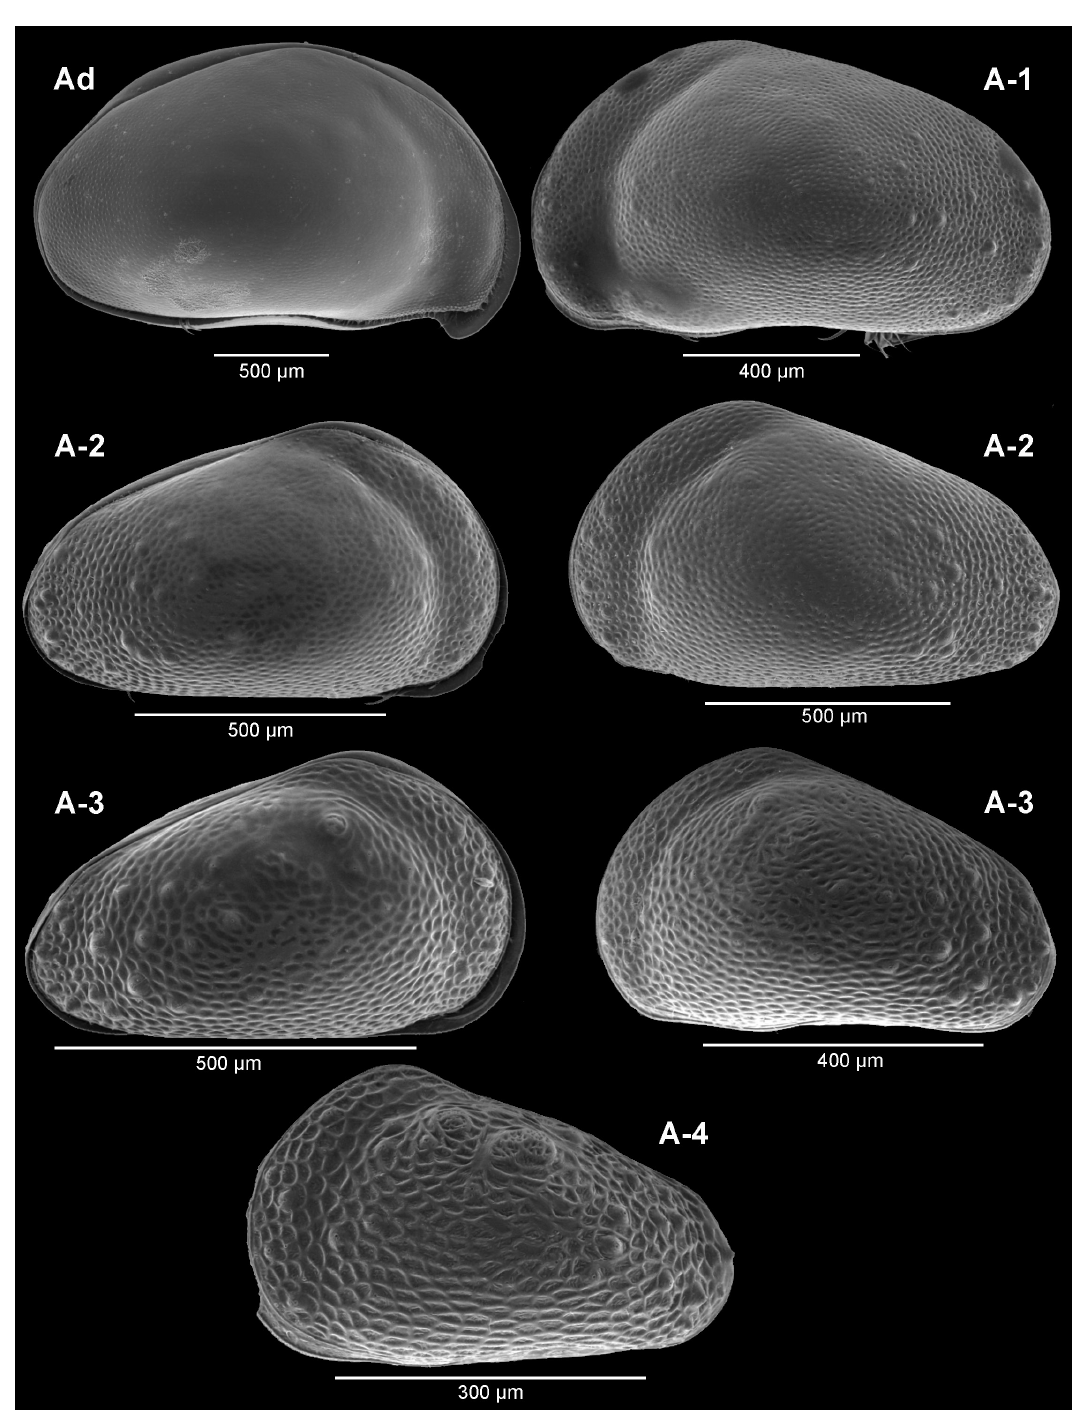
Fig. 14. Bennelongia kimberleyensis Martens et al ., 2012 from Taylor’s Lagoon. Lateral views of carapaces of different moult stages going from adult to A-3 specimens, plus a lateral view of a single LV of an A-4 specimen (bottom image) that is partly broken along its anterior margin. Top left image represents an adult showing the asymmetric valves, with the antero-ventral beak-like expansion of the LV that is the characteristic of most Bennelongia species in the adult stage. Right lateral views are in the left column, left lateral views are in right column. Note that the pseudo-punctation is more pronounced in the youngest stages compared to the almost smooth nature of the adult